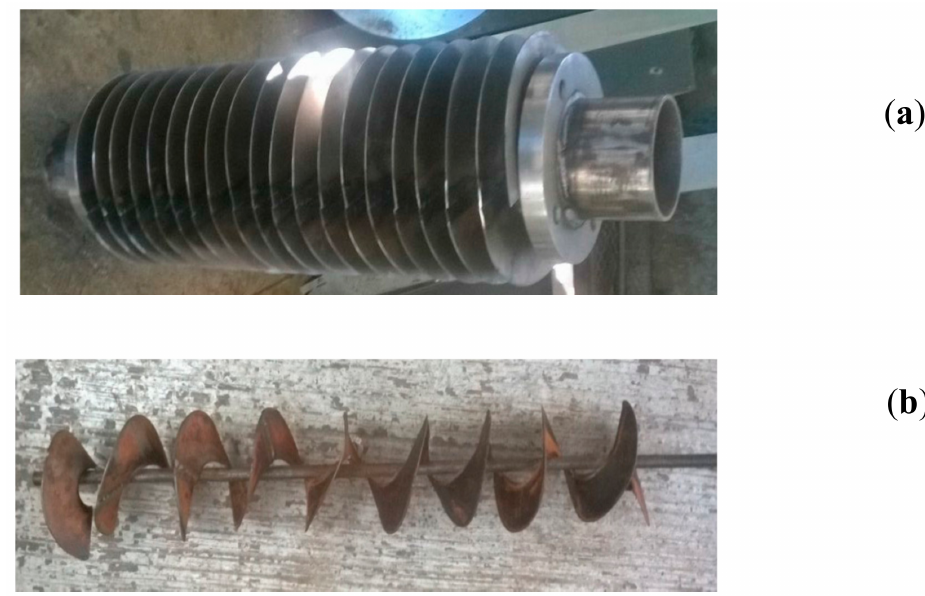
Figure 3. Picture of the helical mixer inserted in the ( a ) annulus and ( b ) central